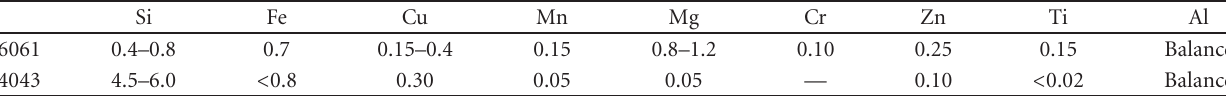
Table 1: Nominal chemical composition of materials used (wt.%).